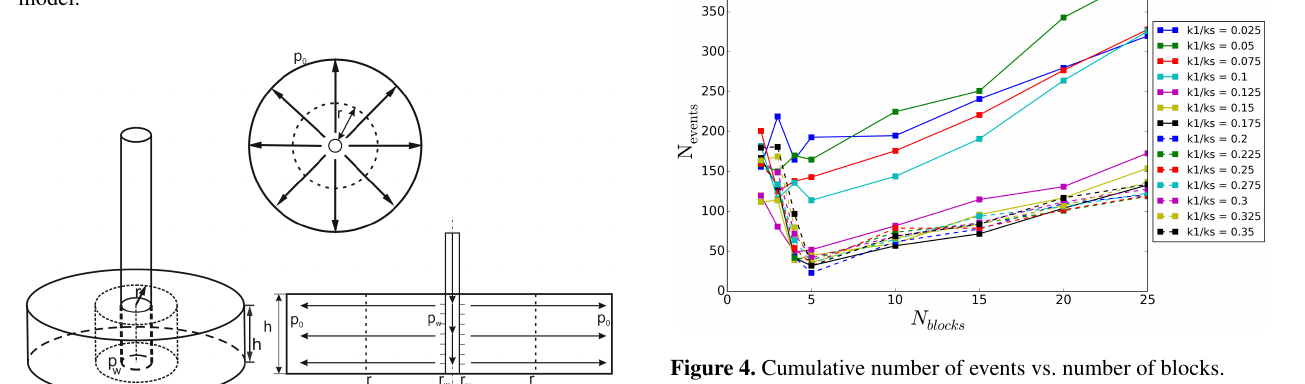
Figure 1. (a) The block model of an active tectonic fault; (b) schematic diagram of a multi-degree-of-freedom spring-block model.